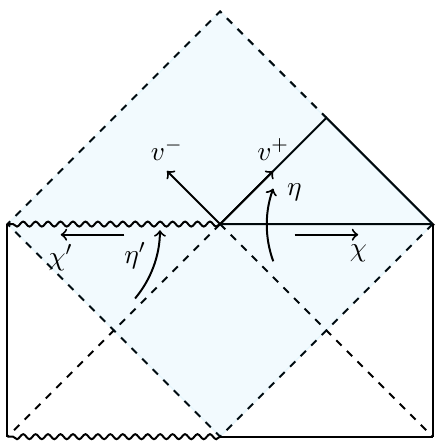
Figure 28 . The conformal field is in the vacuum state of a Minkowski spacetime as shaded in blue, which is conformally equivalent to the original metric. We can parametrize the region with coordinates v ±